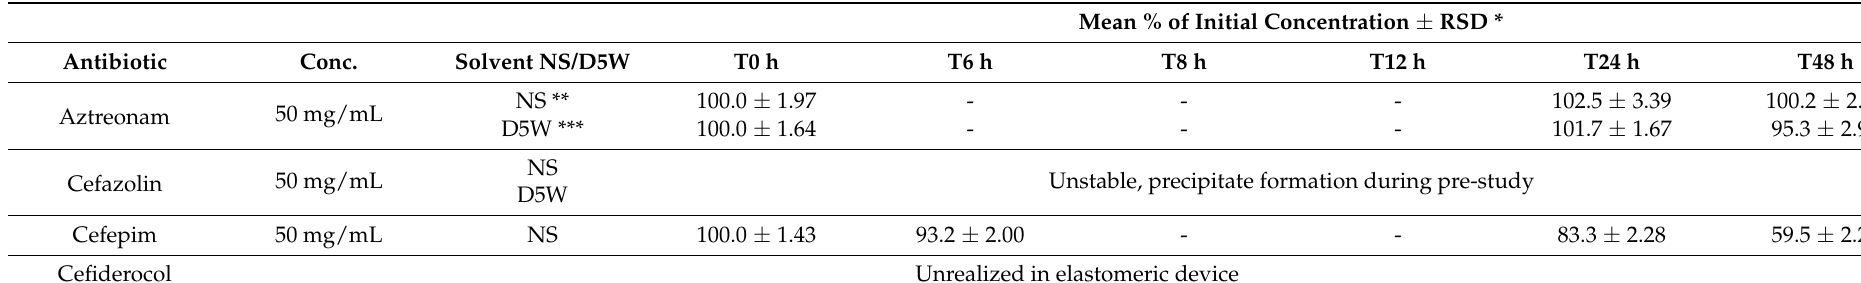
Table 3. Stability of antibiotics in polyisoprene elastomeric devices for use in OPAT at 37 ◦ C measured by